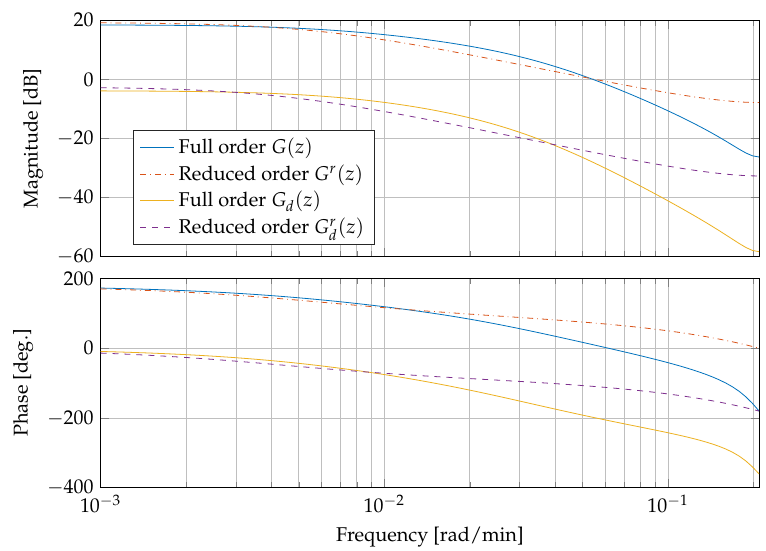
Figure 5. Frequency response of the plant and the disturbance dynamics, comparing full order models ¯ G ( z ) and ¯ G d ( z ) and reduced order models